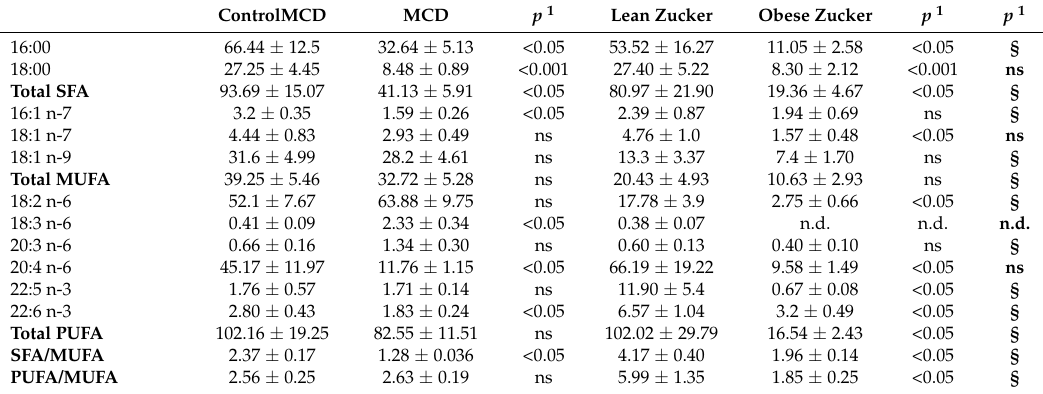
Table 4. Hepatic fatty acid composition in MCD and Obese Zucker